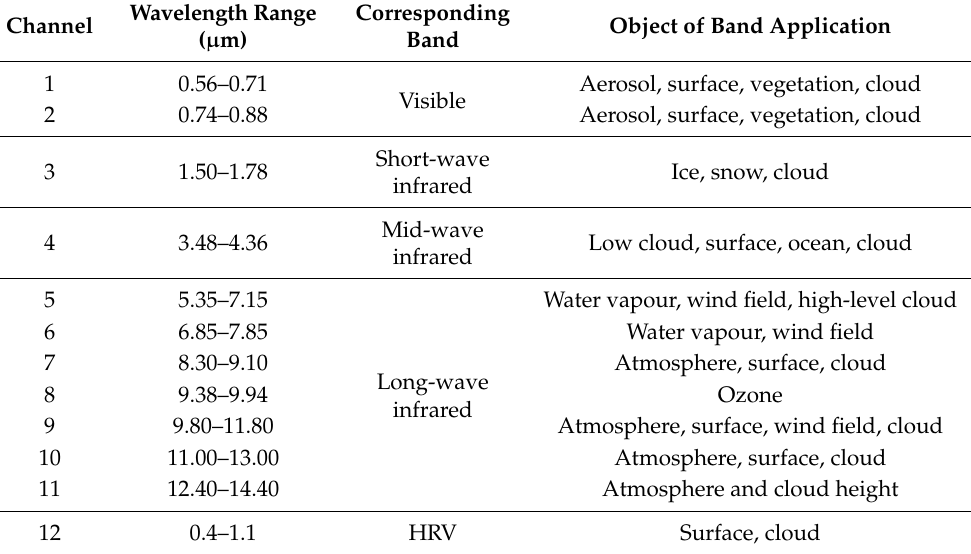
Table 1. Wavelength range of different SEVIRI channels and application objects of each channel.